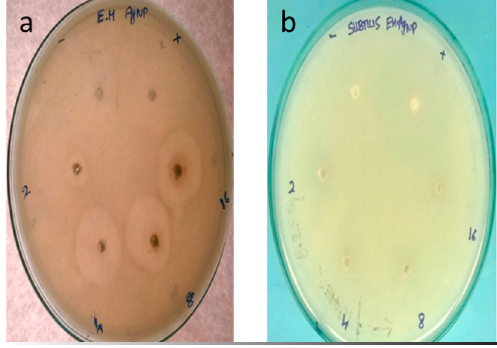
Fig. 6. Antibacterial activity of crude silver nanoparticles against a) Pseudomonas aeruginosa b) Bacillus